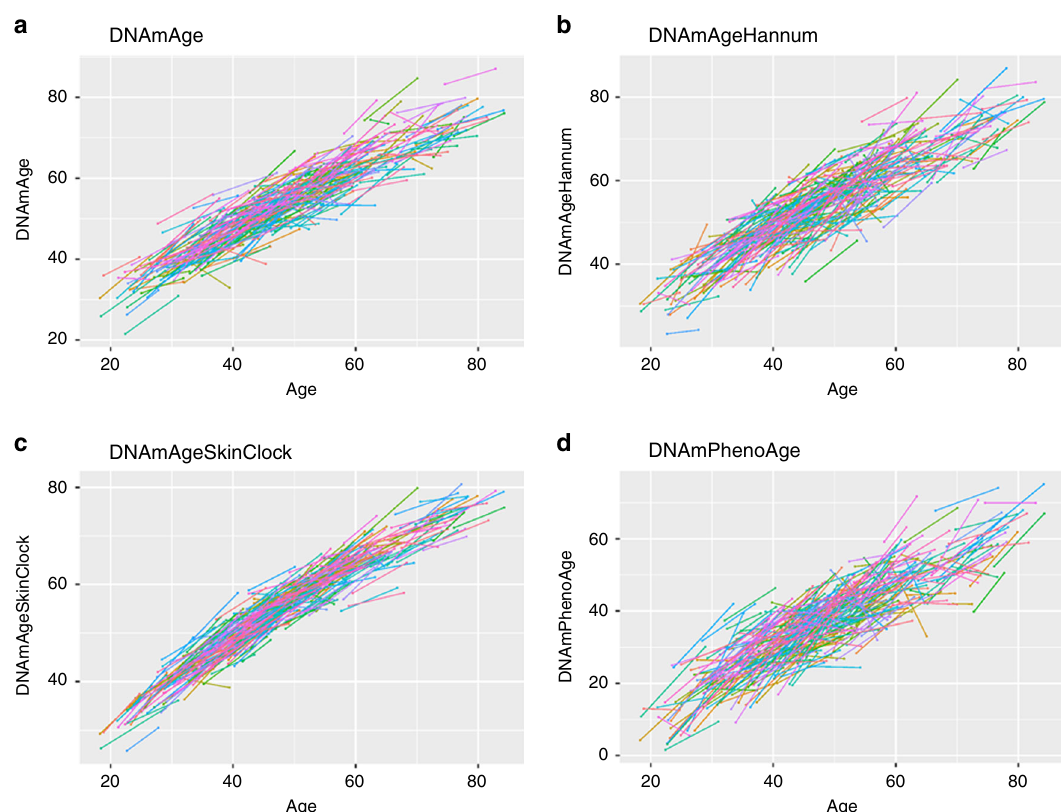
Fig. 2 Spaghetti plots of DNA methylation age versus chronological ages in the longitudinal Enroll-HD data 2. Each spaghetti plot depicts DNAm age versus chronological age, using the Enroll-HD data 2 with two time-points per individual. Each line connects two blood draws from the same individual collected on average 7.9 years apart. The panels report results for different epigenetic clocks a Horvath ’ s pan-tissue clock 14 , b Hannum ’ s blood-based clock 15 , c the skin and blood clock 16 , and d and DNAm PhenoAge 17 . The same analysis was not performed on DNAmGrimAge because it is a mortality risk predictor that uses age in its de fi of epigenetic AgeAccel exhibit nominally signi fi cant positive correlations with motor progression (e.g., r = 0.08, meta-analysis p = 0.016 for the pan-tissue clock; Supplementary Table 8 and Supplementary Fig. 7).